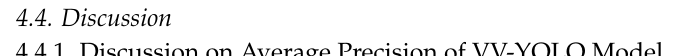
Figure 14. Training average precision change curve of VV-YOLO model.